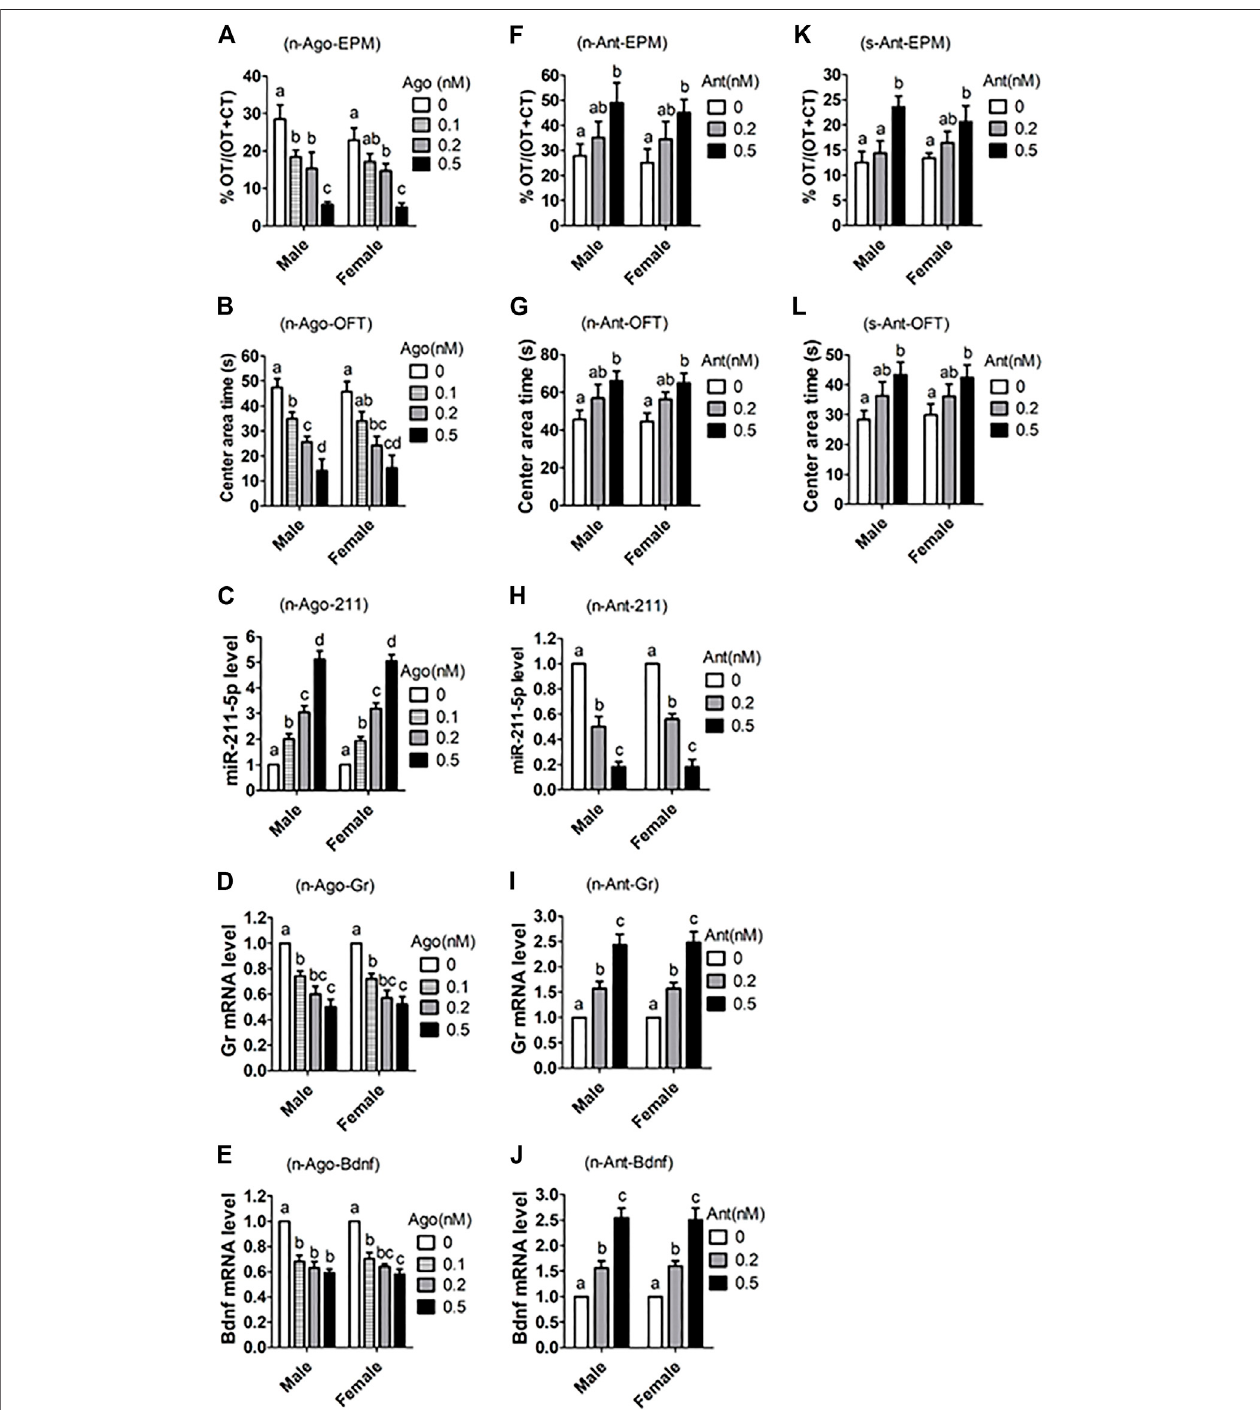
FIGURE 6 | Effects of intrahippocampal injection of miR-211-5p agomir or antagomir on ALB and expression of related genes in hippocampus. Naive (n) or stressed (s) mice were intrahippocampally injected with different concentrations (nM) of miR-211 agomir (Ago) or antagomir (Ant) or scrambled negative control (0 nM). While the naive mice were randomly bred in the laboratory, the stressed mice were offspring from PIRS mothers at the same age (8 – 9 weeks after birth). The ALB was measured by % Open-arm time (OT)/OT + Closed arm time (CT) during EPM, and by times (s) in central area during OFT. For behavioral tests, each treatment was repeated 7 to 9 times with each replicate including one mouse, and for real-time PCR, each treatment was repeated three times with each replicate containing one mouse. (A – E) ALBandrelated parametersafternormalmicewereinjectedwithmiR-211agomir, (F – J) ALBandrelatedparametersafternormalmicewereinjectedwith miR-211 antagomir. (K,L) ALB after stressed mice from PIRS mothers were injected with miR-211 antagomir. a – d: Values without a common letter above bars differ signi fi cantly within sexes.